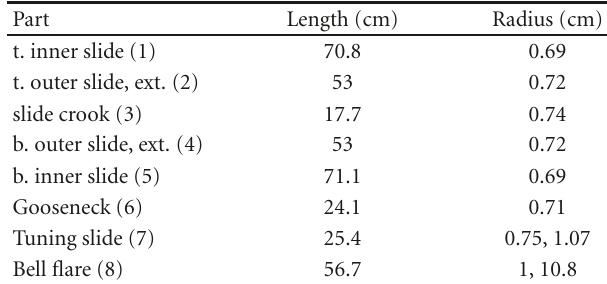
Table 2: Trombone tubular sections (numbers correspond to parts in Figures 17 and 18) and dimensions,including top (t.) and bottom (b.) inner and outer slides, retracted and extended